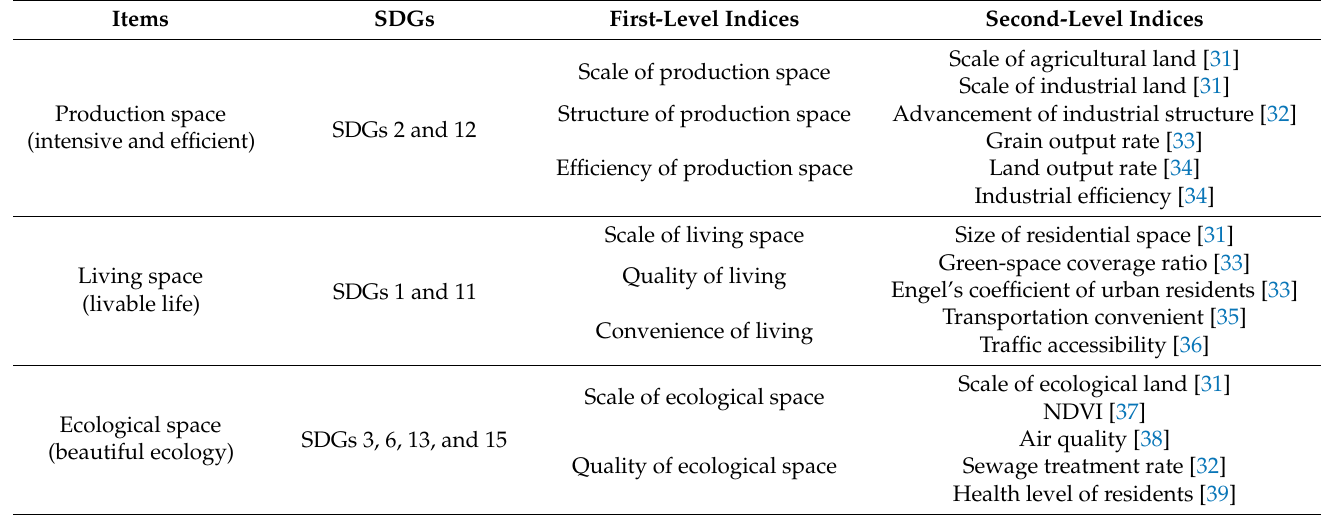
Table 3. Index system of spatial coupling coordination degree evaluation for sustainable development goals